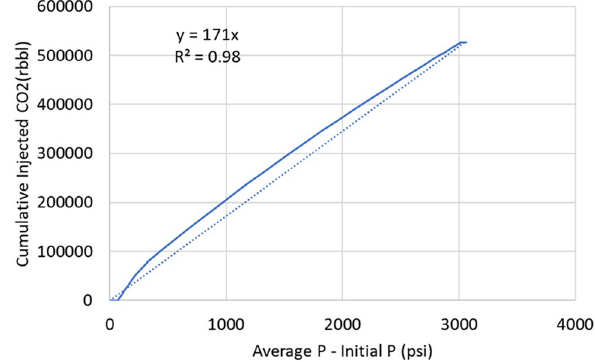
Fig. 3 Predicted cumulative injected CO oil-saturated reservoir using numerical simulation and applied linear regression using Eq.